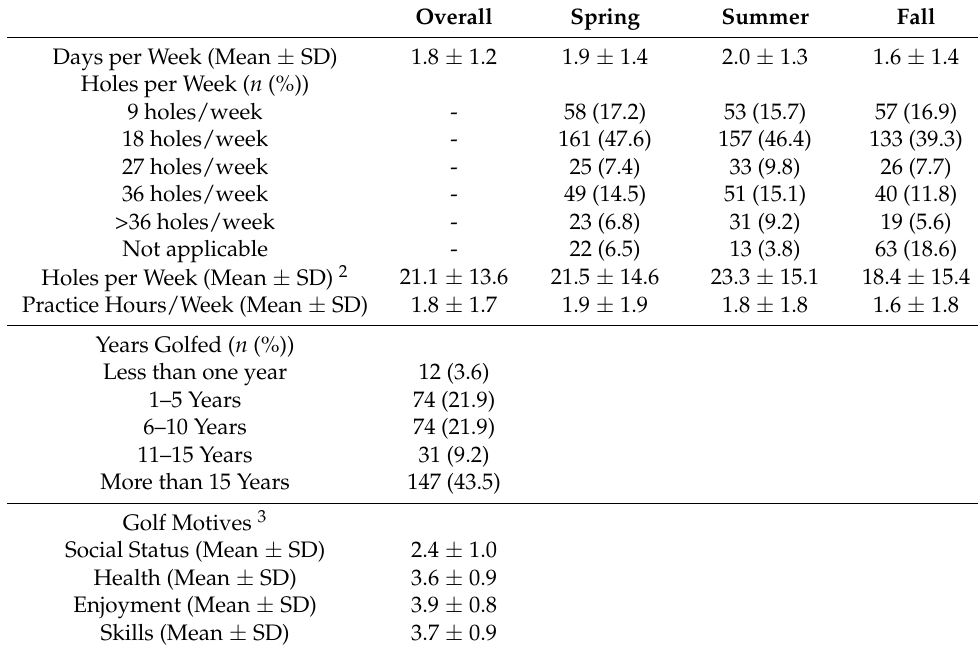
Table 3. Golf participation and motives 1 .